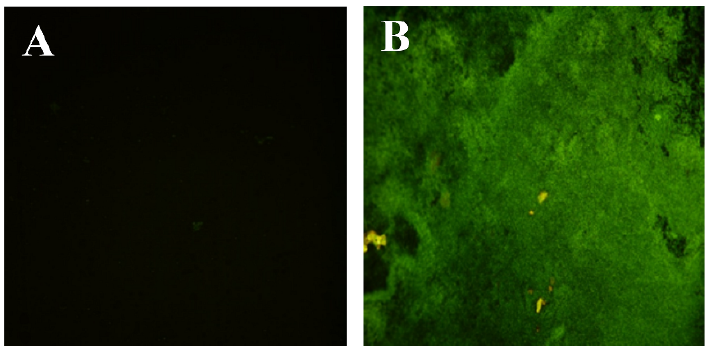
Figure 7. Fluorescence microscopy images of a biofilm formed on a cellulose acetate (CA) membrane before ( A ) and after 10-min nonthermal plasma treatment ( B ). Images obtained at a magnification of 20.